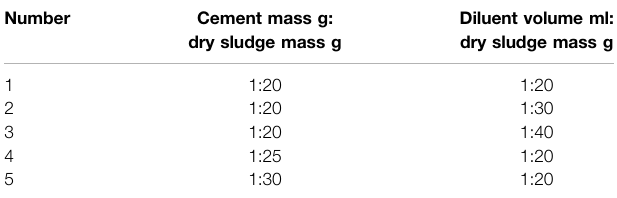
TABLE 2 | Test mix ratio of solidi fi ed muddy